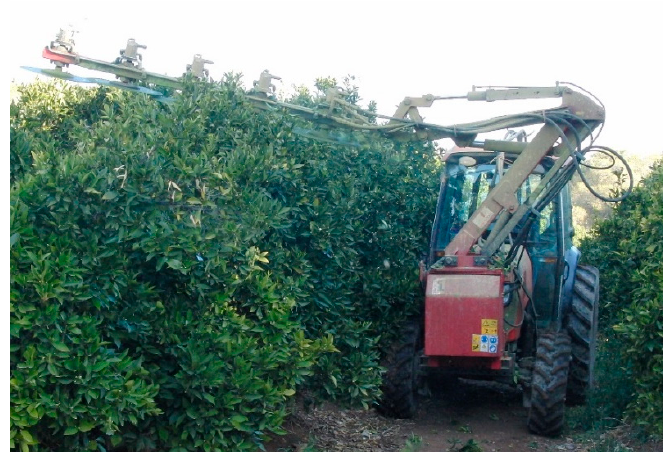
Figure 1. The tractor disc pruner used in the trials. Furthermore, after pruning, the pruned fresh biomass was characterized. In a mini- mum of 100 branches for each type of cutting (topping, hedging, skirting, and manual), the length (cm) and the diameter in the cutting area (mm) were measured. The quantity of fresh biomass removed with each strategy was measured (kg tree − 1 ). For this, all of the cut branches of each type of cutting of the tree under study of each strategy and repetition were weighed with a digital dynamometer (Advanced Force Gauge 500 N, Mecmesin Ltd., by adding the weights obtained in the different types of cuts included in each